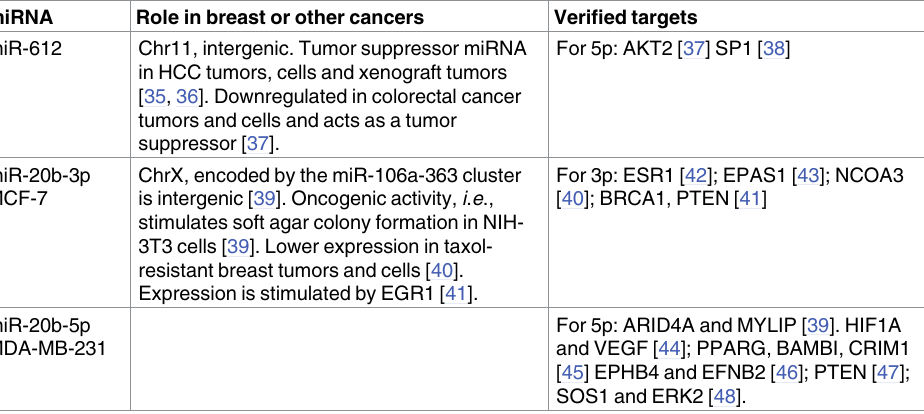
Table 2. miRNAs upregulated by AnAc in both MCF-7 and MDA-MB-231 cells. The genomic locationof each miRNA was identifiedin miRAD http://bmi.ana.med.uni-muenchen.de/miriad/ [34]. Verified targets are those experimentally validatedtargets of the indicatedmiRNA as demonstrated by 3’-UTR luciferasereporter assay. Since many publicationsdo not includewhetherthe 5p or 3p arm of the miRNA was studied, if the sequenceof the miRNA was provided,it was searchedin miRBase.org to identify which arm was used in the target gene3’-UTR luciferase reporter assay. miRNA Role in breast or other cancers Verified targets miR-612 Chr11, intergenic. Tumor suppressor miRNA For 5p: AKT2 [37] SP1 [38] in HCC tumors, cells and xenograft tumors [35, 36]. Downregulated in colorectal cancer tumors and cells and acts as a tumor suppressor [37]. miR-20b-3p ChrX, encoded by the miR-106a-363 cluster For 3p: ESR1 [42]; EPAS1 [43]; NCOA3 MCF-7 is intergenic [39]. Oncogenic activity, i . e ., [40]; BRCA1, PTEN stimulates soft agar colony formation in NIH- 3T3 cells [39]. Lower expression in taxol- resistant breast tumors and cells [40]. Expression is stimulated by EGR1 [41].